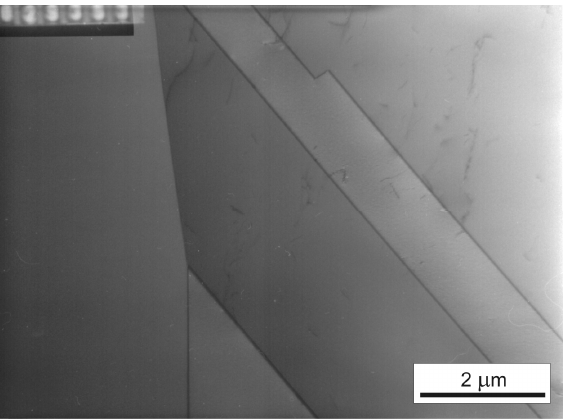
Figure 2. Typical microstructure of the initial state of the tested steel (TEM).